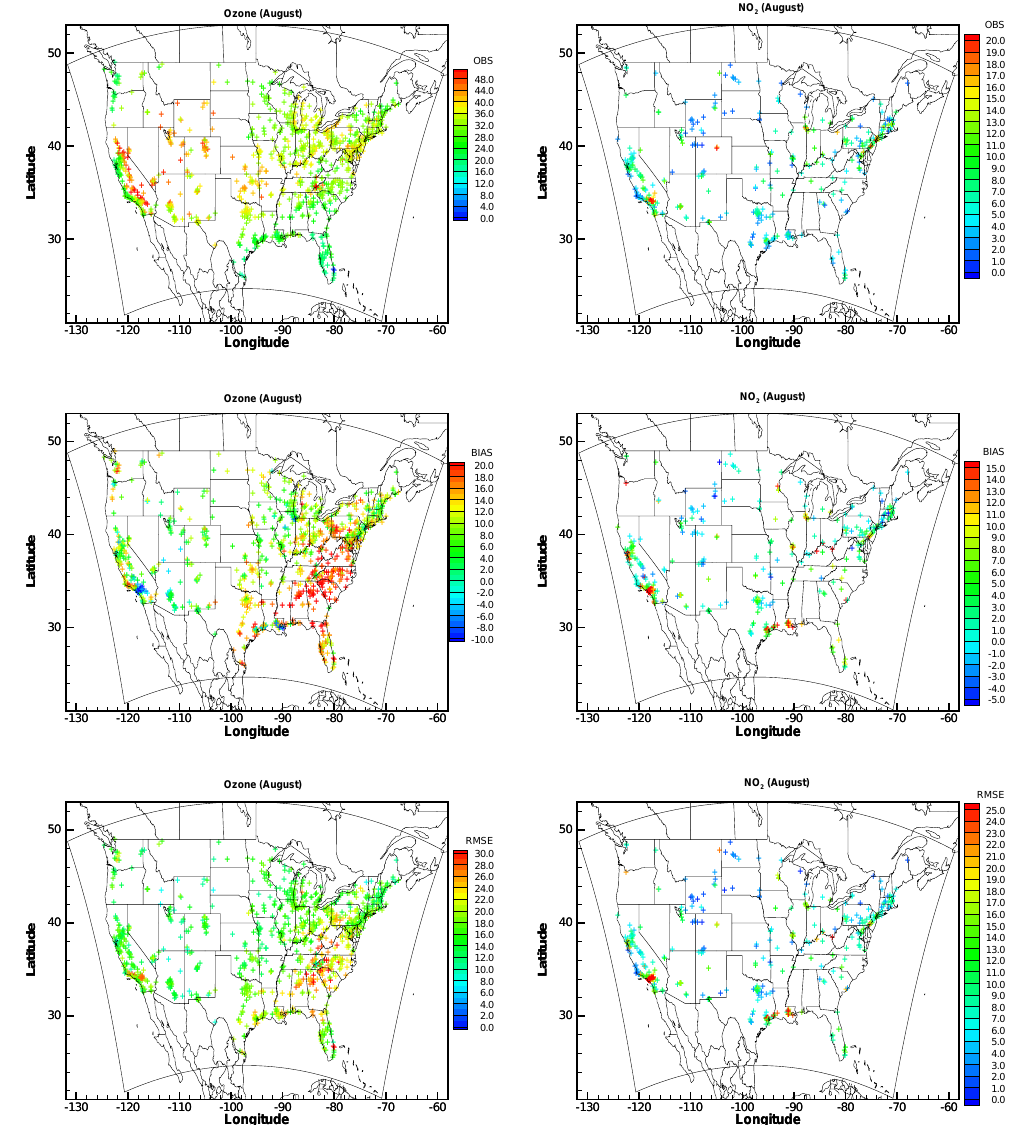
Fig. 8. Spatial distributions of ozone (left) and NO 2 (right) measurements (upper panels), model biases (middle panels), and RMSEs (lower panels) in August 2010. Unit: